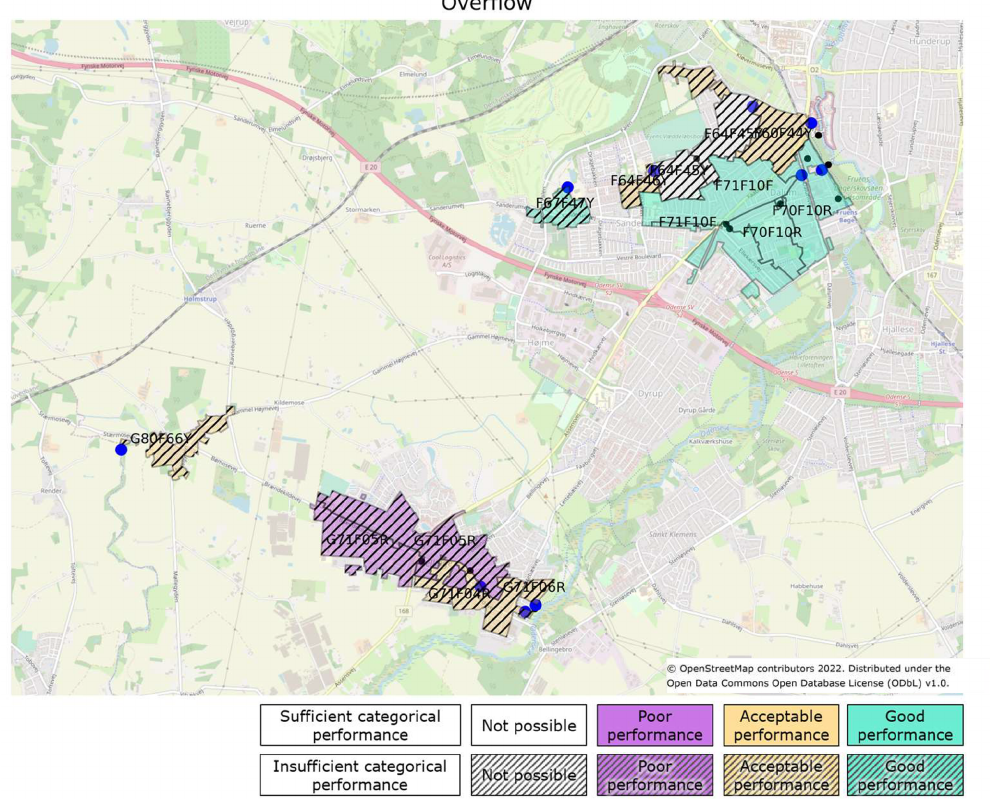
Figure 10. Map of the performance for overflow using the method of linear regression. The upstream catchment area of the site is mapped, and the naming in the catchment refers to the overflow structure that is mapped. The catchment area represents the case areas. The urban areas in between the catchment areas are not connected to the case areas, as they have a separate storm water system. Background map is from OpenStreetMap